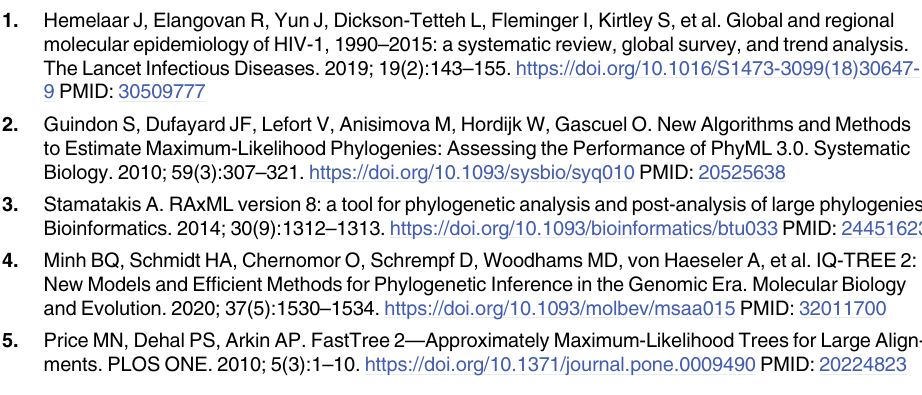
S5 Fig. Similarity of model predictions on Russian dataset when presented by year. Models with smaller window sizes give similar predictions, an advantage over models with larger win- dow sizes. S1 Text. Supporting tables for neural network construction and model robustness against